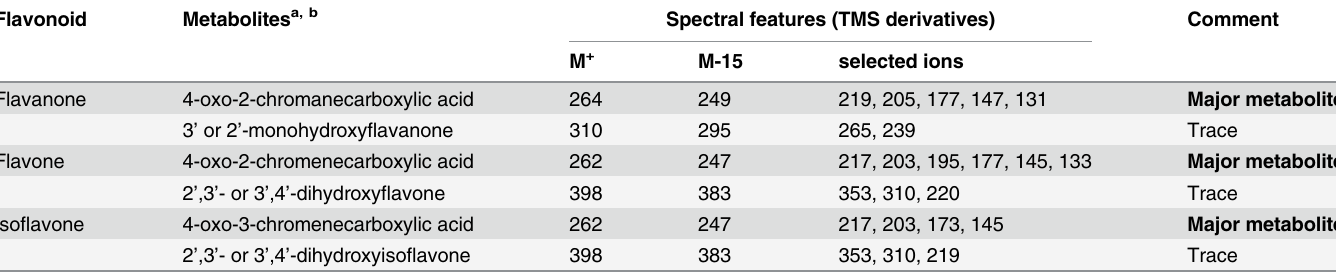
Table 3. Metabolites produced by strain U23A during co-metabolic growth on simple flavonoids. Flavonoid Metabolites a, b